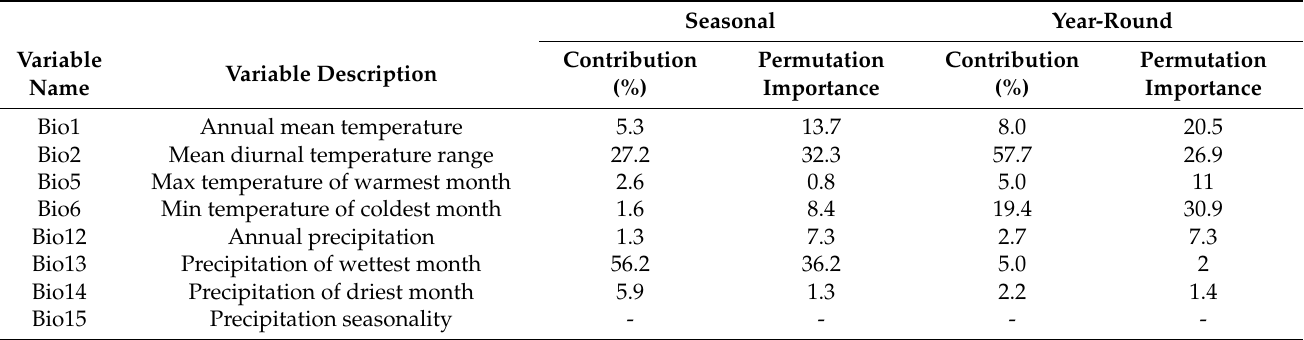
Table 2. Percentage contributions and permutation importance of the bioclimatic variables included in the MaxEnt models for seasonal occurrence and year-round occurrence of Bactrocera dorsalis . Here we list the results from best models based on set